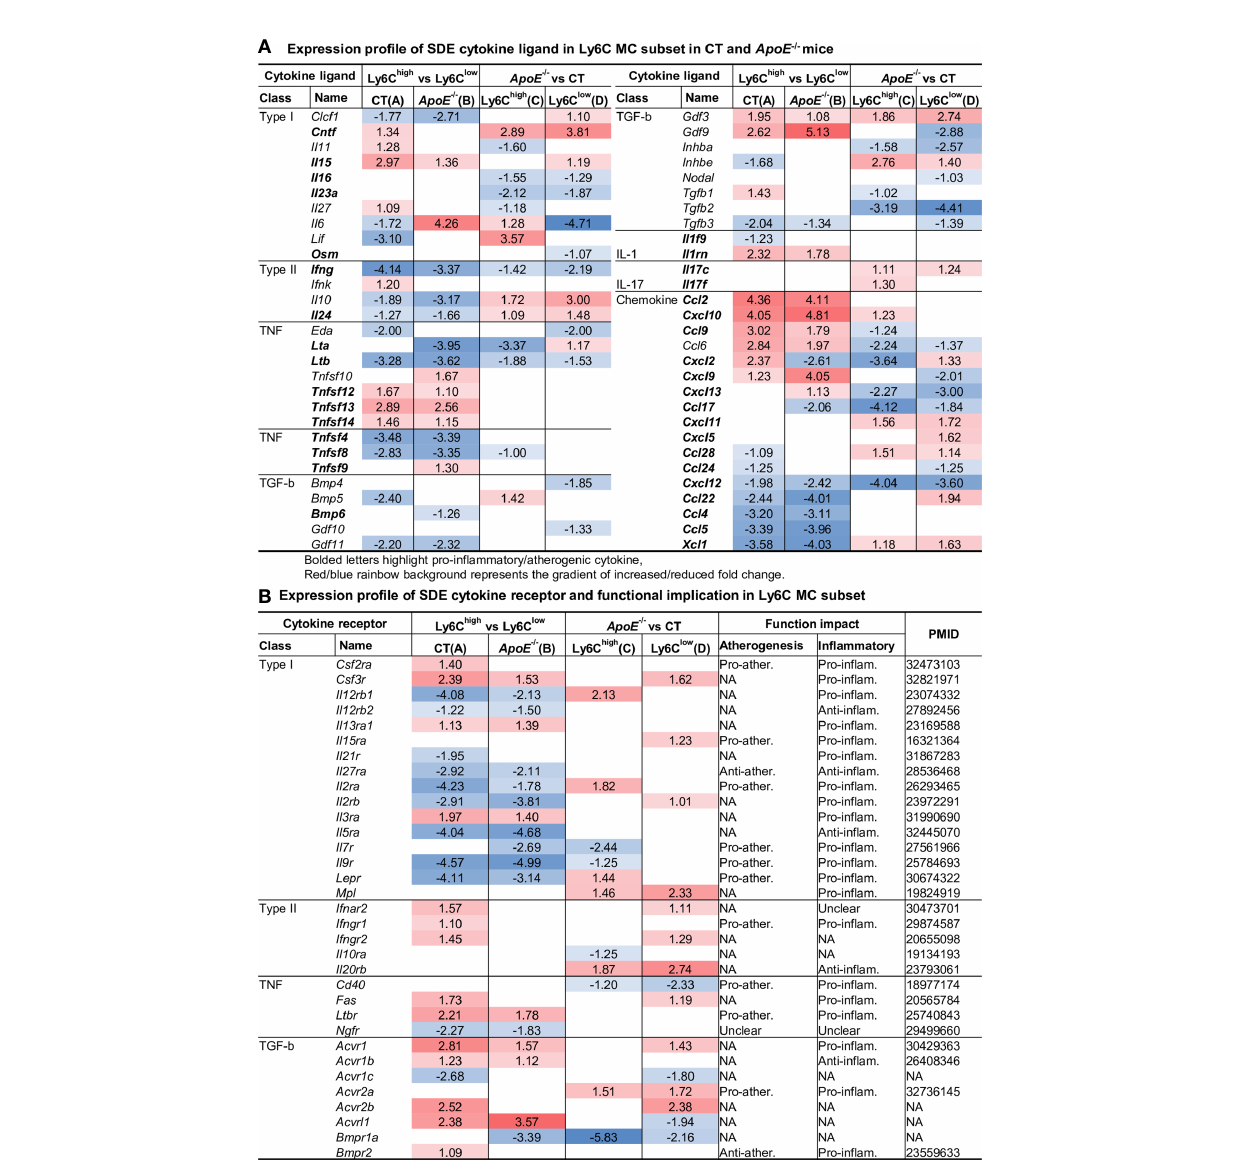
FIGURE 5 | Identi fi cation of SDE immune checkpoint gene and function implication in Ly6C MC subset in CT and ApoE -/- mice. (A) Expression pro fi le of SDE immune checkpoint gene. Sixteen pairs of SDE co-stimulatory and 11 pairs of SDE co-inhibitory molecules are identi fi ed in four comparison groups. (B) SDE immune checkpoint gene functional implication in Ly6C MC subsets in ApoE -/- mice. ↑ refers to induce expression by ApoE -/- . ↓ refers to reduce expression by ApoE -/- , ± refers to no changes in ApoE -/- . (C) Model of SDE immune checkpoint gene and functional implication. Red letter highlighted the representative up- regulated gene. Blue letter highlighted down-regulated genes. Bold letter emphasized pro-atherogenic function. NA, Not